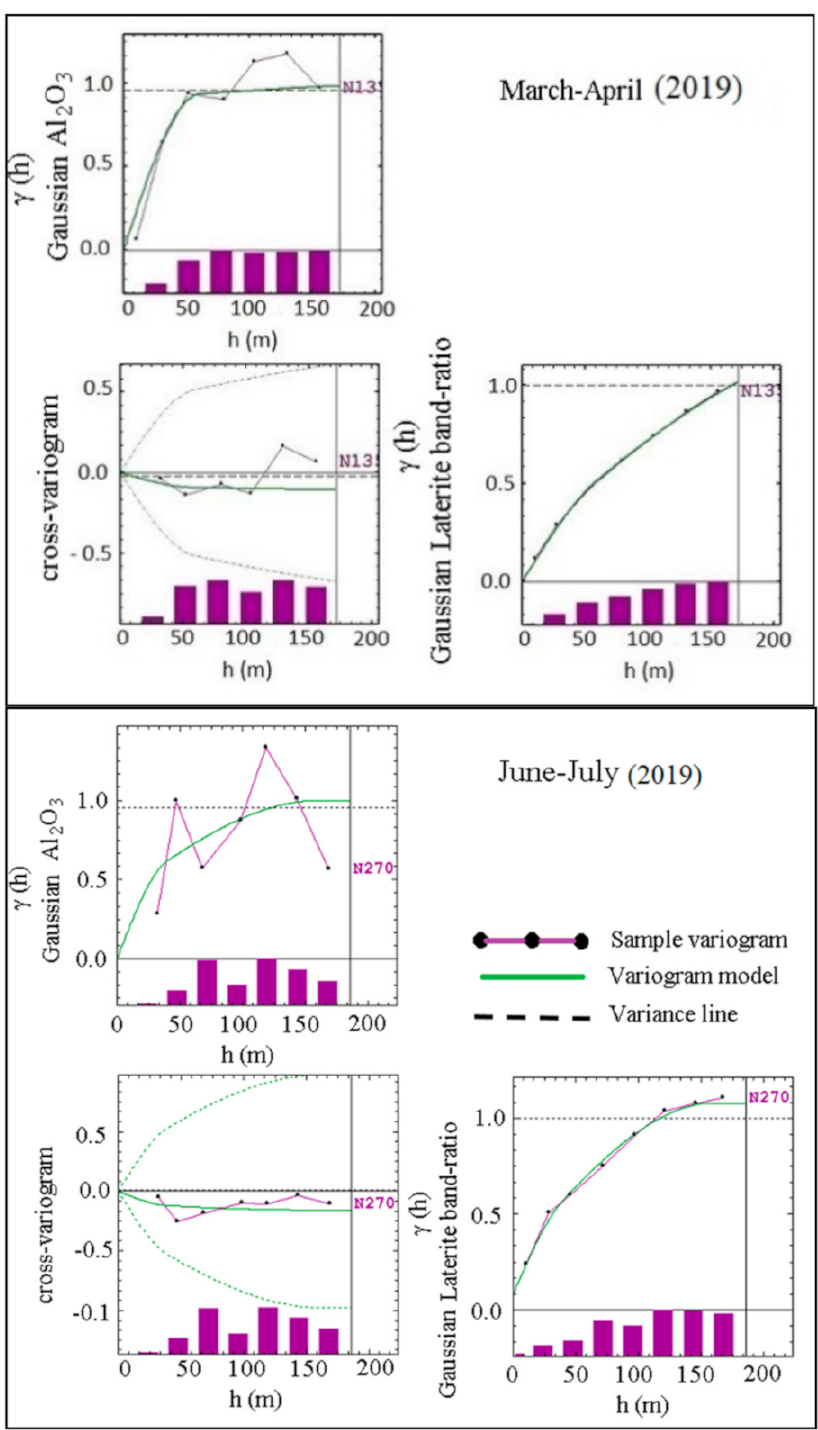
Figure 8. Direct and cross-variograms between Al 2 O 3 and laterite band ratio with histograms of pair numbers in each variography, histograms show the sample pairs number used for variogram